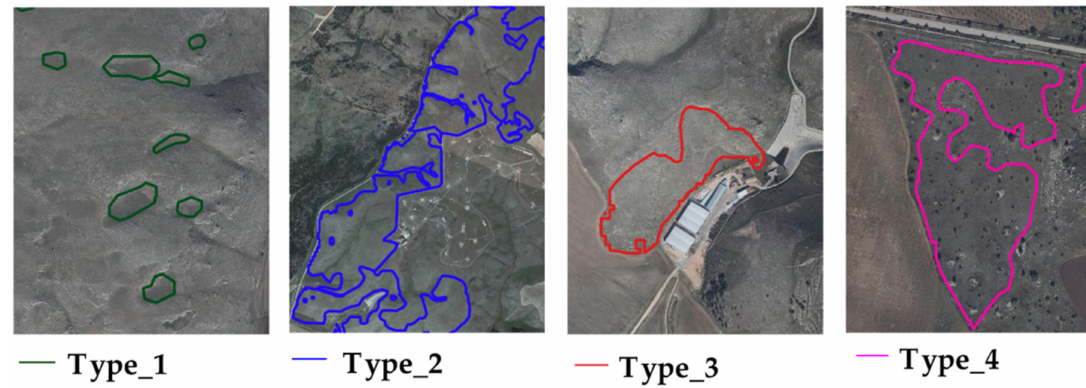
Figure 2. Ground truth polygons overlaid on an orthophoto (2018) for different habitat classes investigated. For each class, the percentage of 75% (54,725 pixels) from the available ground truth samples was randomly selected for training and testing. Validation of the classifier was performed using the 100% (73,386) of ground truth data in a k-fold procedure. Figure 3 shows ground reference samples distribution for each grassland habitat class.